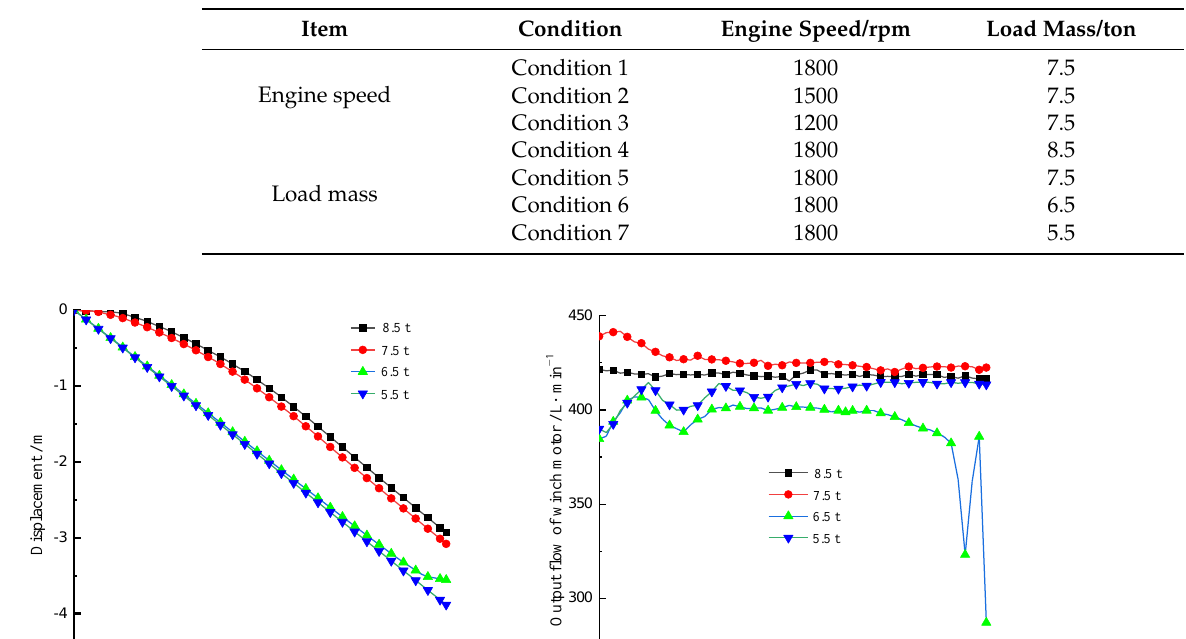
Table 2. Different working conditions of the winch.